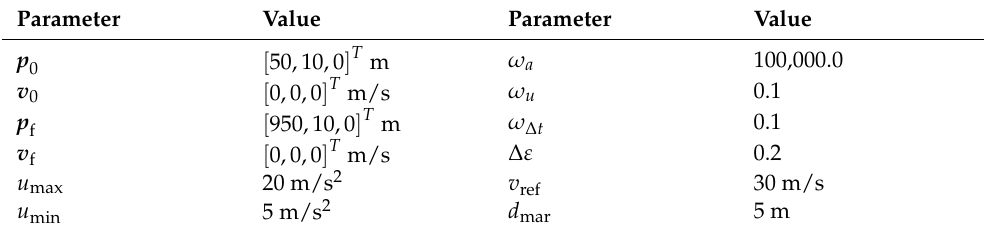
Figure 6. Example 1 ′ s MSD fields with different homotopy parameters. ( a ) ε= 0.0 , ( b ) ε= 0.33 , ( c ) ε= 0.67 , and ( d ) ε= 1.0 . Table 5. Parameter setting of Example 1.